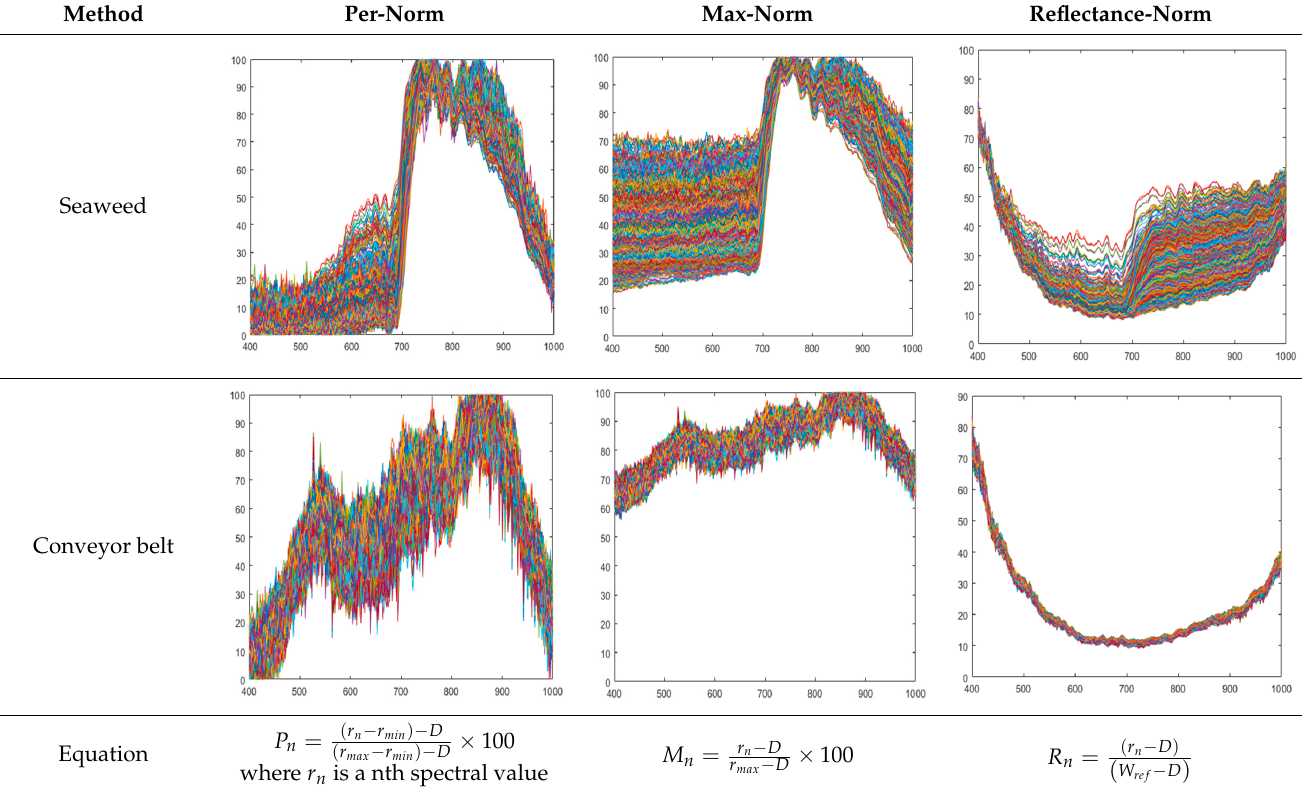
Table 4. Detection performance of each Table 4. Detection performance of each algorithm. Table 4. Detection performance of each algorithm. Table 4. Detection performance of each algorithm. Table 4. Detection performance of each algorithm. Table 4. Detection performance of each algorithm.